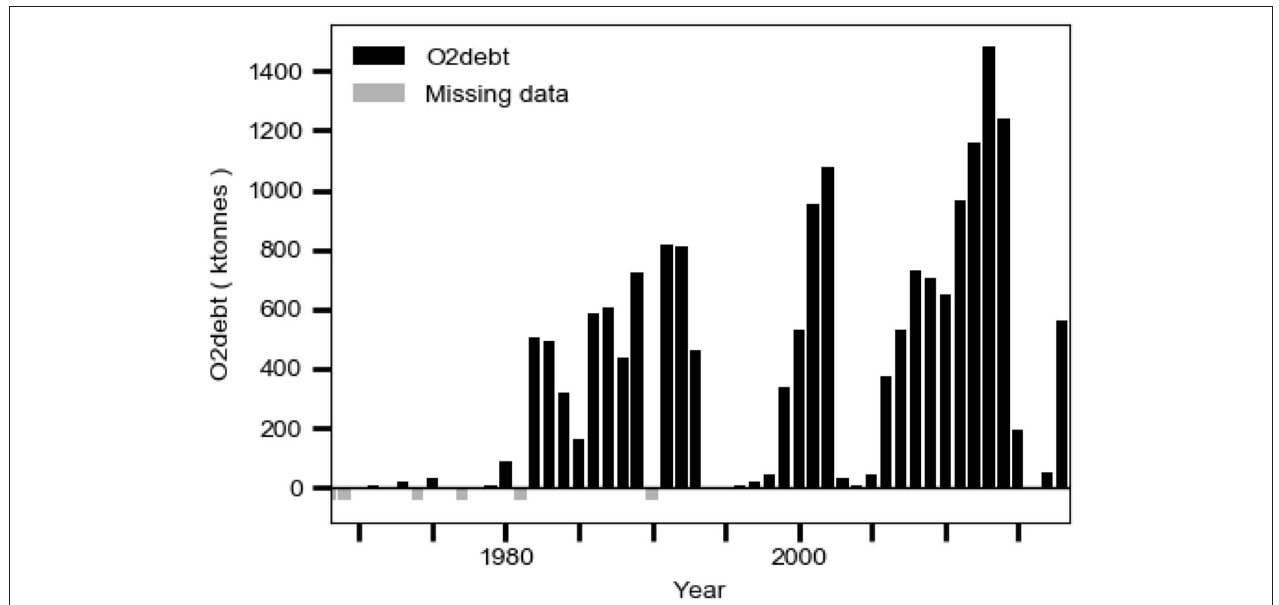
FIGURE 11 | The evolution of the oxygen debt O2debt in the East Gotland Basin computed from hydrographical data from station BY15 in the period 1968–2018 as described in the section